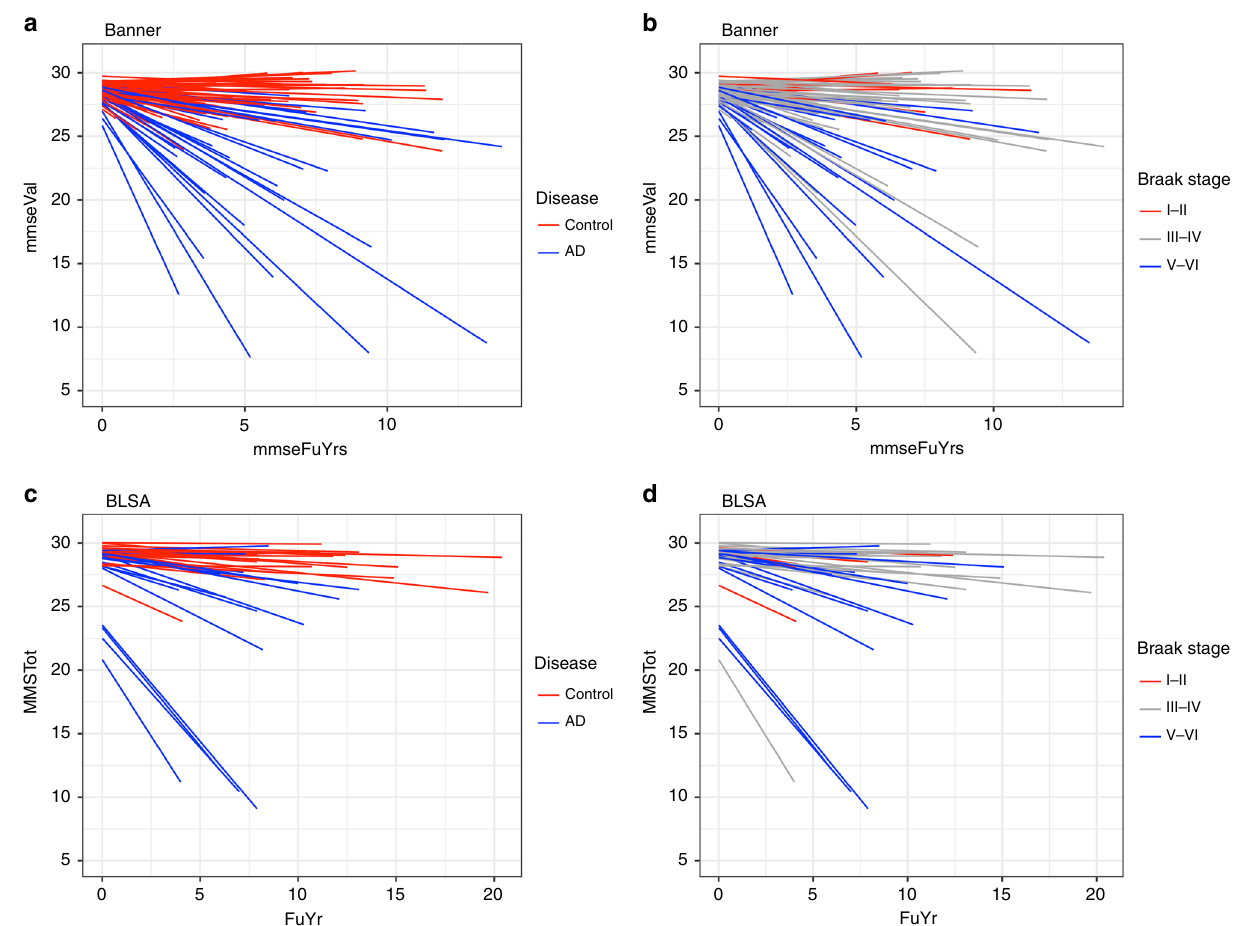
Fig. 2 Person-speci fi c cognitive trajectory. This fi gure summarizes cognitive trajectory for each individual with colors indicating clinical diagnosis and Braak stage. Individual cognitive trajectory in the Banner cohort by a last clinical diagnosis (AD or control) prior to death and b Braak stage. Individual cognitive trajectory in the BLSA cohort by c clinical diagnosis; d Braak stage. A positive slope or small negative slope re fl ects cognitive stability. A larger negative slope re fl ects faster cognitive decline. The underlying data are available through the Synapse platform (protein abundance, https://www.synapse.org/#! Synapse:syn7170616 and https://www.synapse.org/#!Synapse:syn3606086) and Supplementary Data FDR < 0.05 in the same directions in both datasets (Supplemen- tary Data 5).